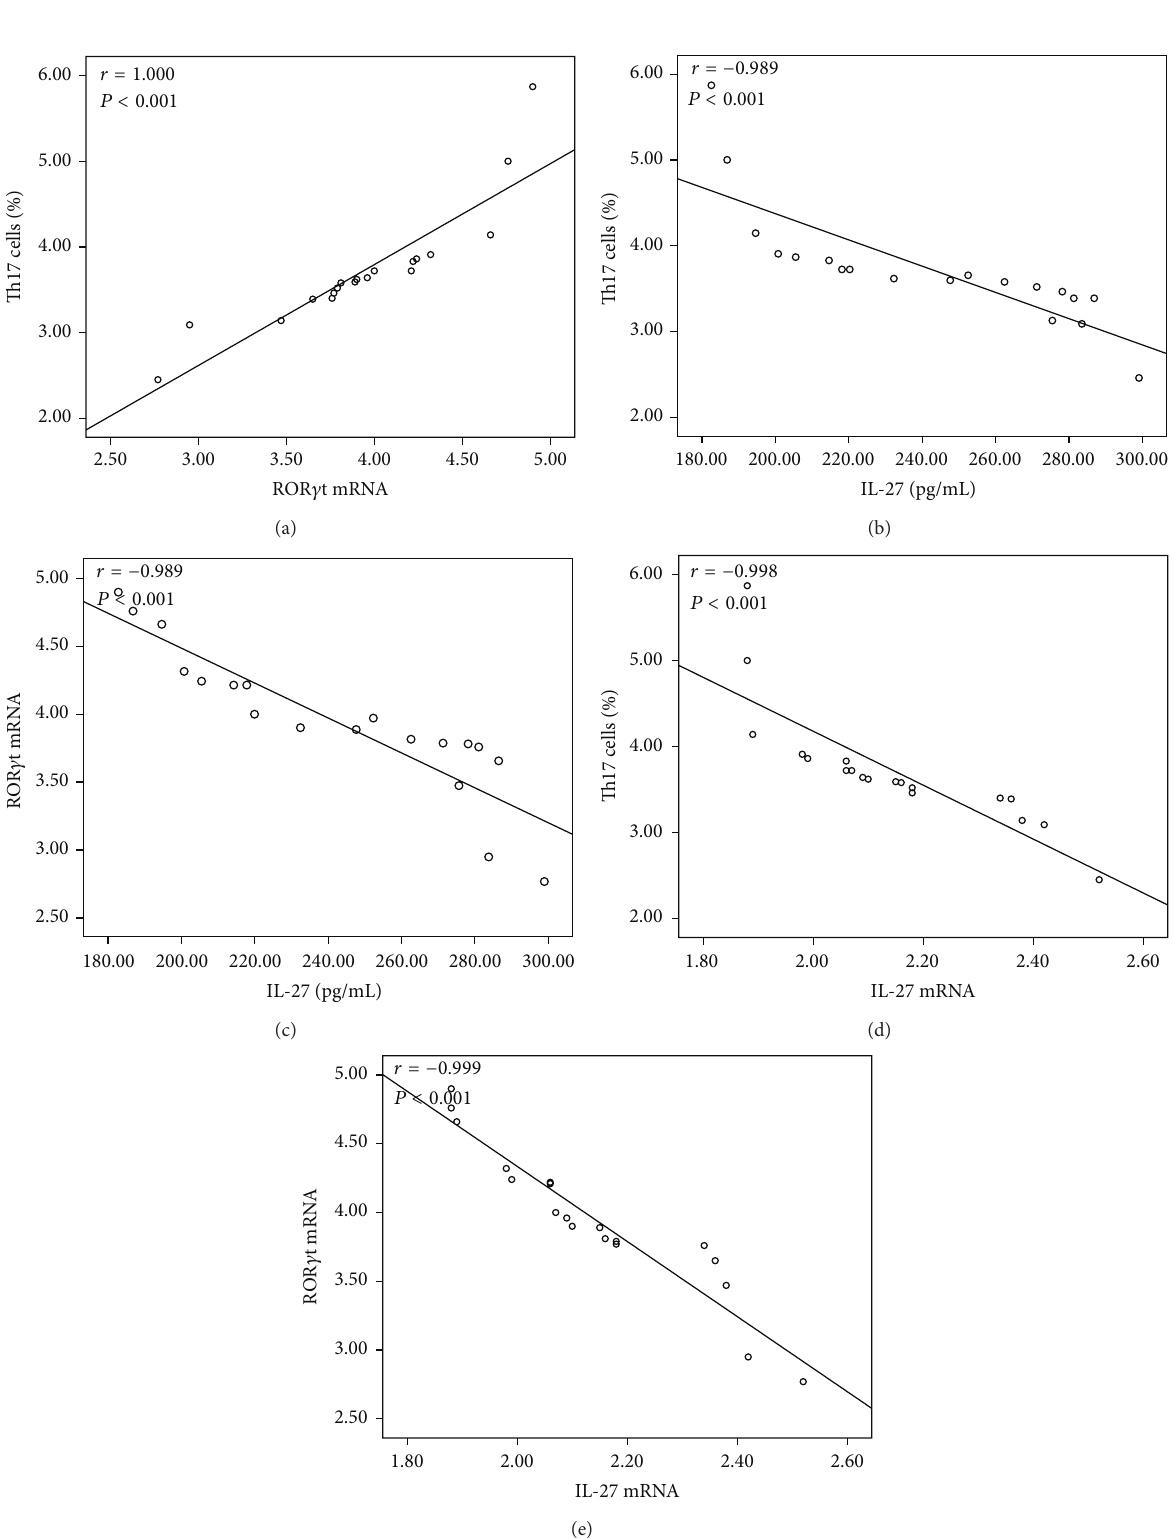
Figure 5: Correlations between (a) the frequency of Th17 cells and ROR 𝛾 t mRNA, (b) the frequency of Th17 cells and IL-27 levels, (c) ROR 𝛾 t mRNA and IL-27 levels, (d) the frequency of Th17 cells and IL-27 mRNA, and (e) ROR 𝛾 t mRNA and IL-27 mRNA in NSCLC patients. Data were determined by Spearman’s rank correlation